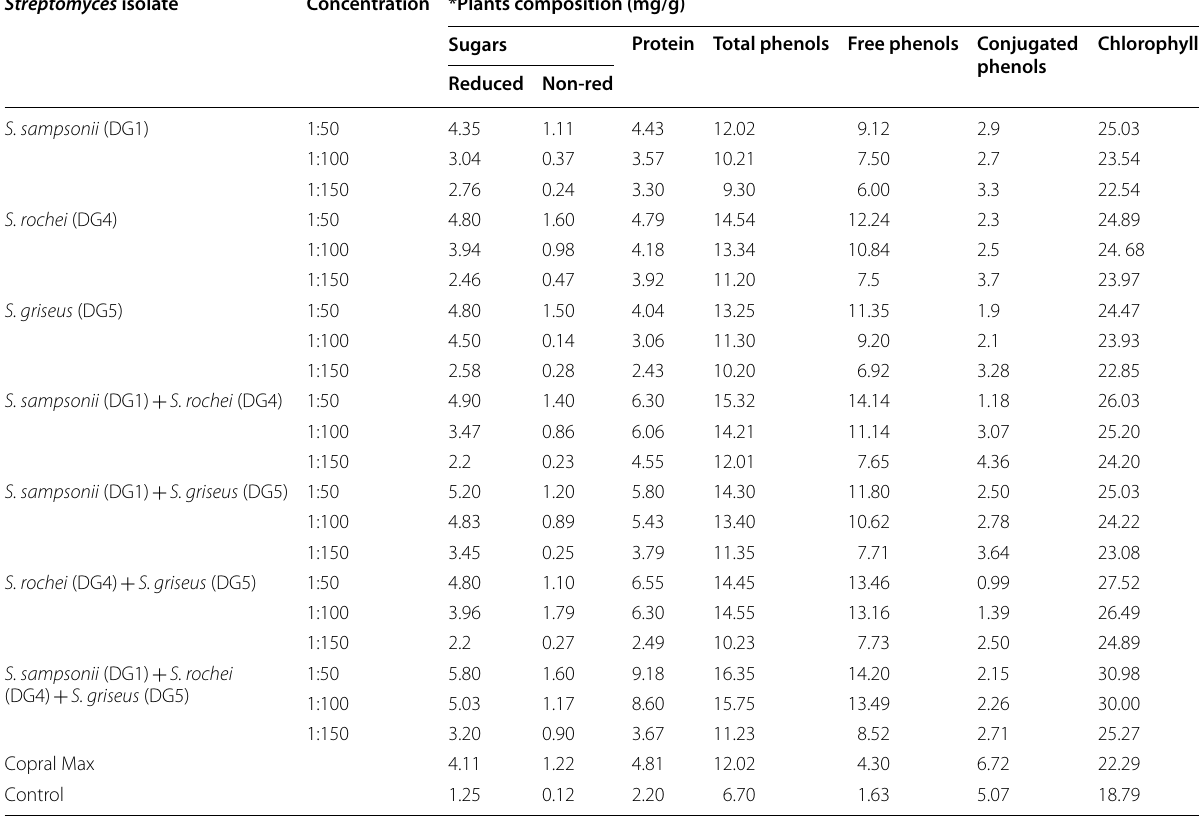
*Data represent one replicate